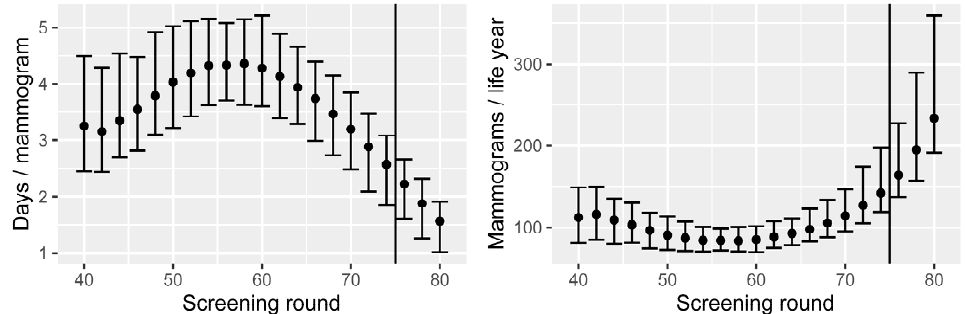
Figure 3. Left: increased life expectancy when attending screening, by screening round, and per mammogram performed. Right: number of mammograms performed per life year gained, by screening round. Means and 90% CIs are based on calibration uncertainty and are calculated as described in Section 3.1.